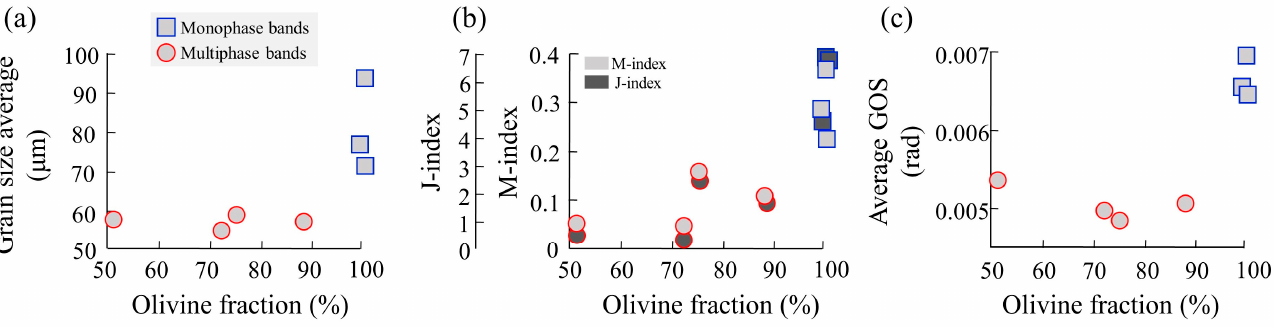
Figure 5. Microstructural properties of olivine from the different bands delineated by white boundaries in Figure 4. Olivine ( a ) grain size, ( b ) texture strength quantified using the M- and J-indices, and ( c ) intragrain misorientation quantified using the grain orientation spread (GOS) are plotted against the area fraction of olivine